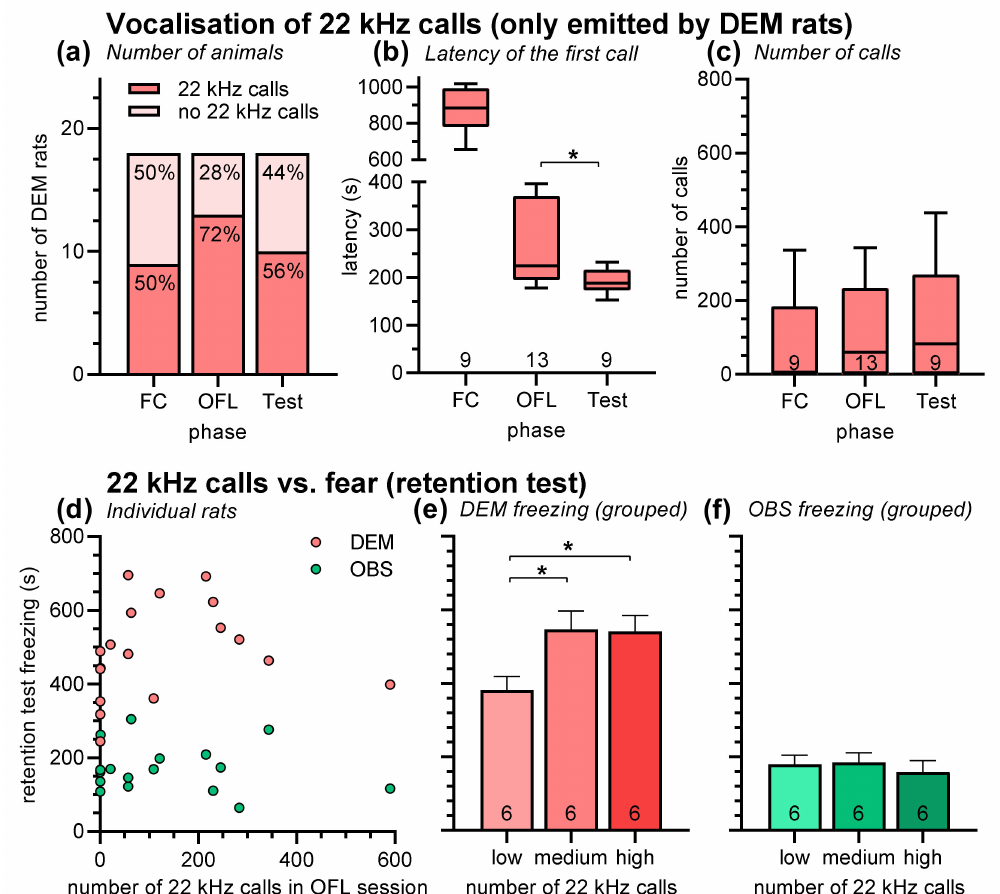
Figure 3. ( a ) Number of rats emitting 22 kHz calls, ( b ) latency of the first 22 kHz call, and ( c ) number of 22 kHz calls in the different phases of the experiment. 22 kHz calls were almost exclusively emitted by DEM rats. There was no difference in the number of rats emitting calls and in the number of calls. However, latency was longest in the fear-conditioning session and significantly longer during the observational fear learning session than during the retention tests. ( d ) Freezing behavior of DEM and OBS rats in the retention session as a function of the number of 22 kHz calls in the observational fear learning session. No correlations were found. ( e ) Next, the observational fear learning session were grouped into sessions with low, medium, and high number of 22 kHz calls. DEM rats of OFL sessions with low number of 22 kHz calls showed lower freezing behavior than the DEM rats from the other session. ( f ) Freezing behavior of OBS rats was not affected by the number of 22 kHz calls in the observational fear learning session. Y -axis scale and units in panels ( e , f ) are the same as in panel ( d ). Abbreviations: DEM, demonstrator rats; FC, fear-conditioning session; OBS, observer rats; OFL, observational fear learning session; Test, retention test. Numbers in or below the bars or boxes indicate group and subgroup sizes. * p < 0.05; comparisons as indicated, after significant main effects in Kruskal–Wallis test or ANOVA,